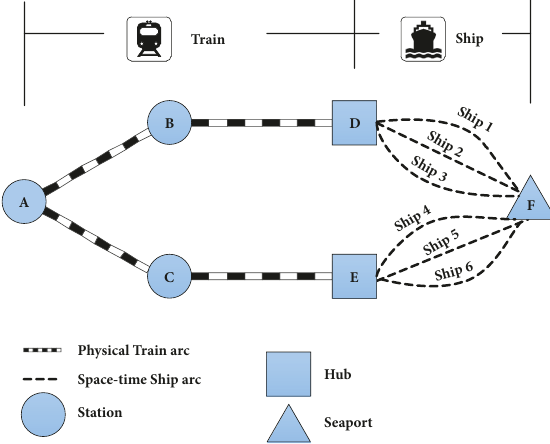
Figure 1: A simple sea-rail intermodal